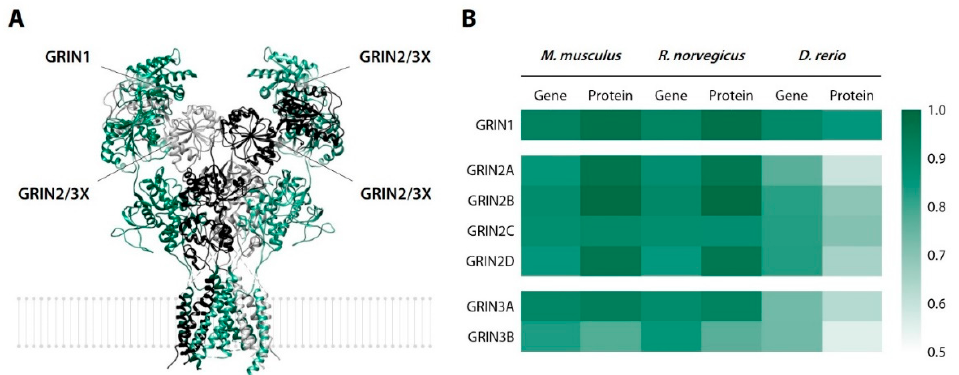
Figure 13. Subunits of N-methyl-D-aspartate receptor as a putative glutamatergic target for chromone-containing allylmorpholines ( A ) and a heatmap of their gene/protein homolog identity to Homo sapiens ( B ). GRIN, glutamate receptor, ionotropic (=N-methyl-D-aspartate receptor).